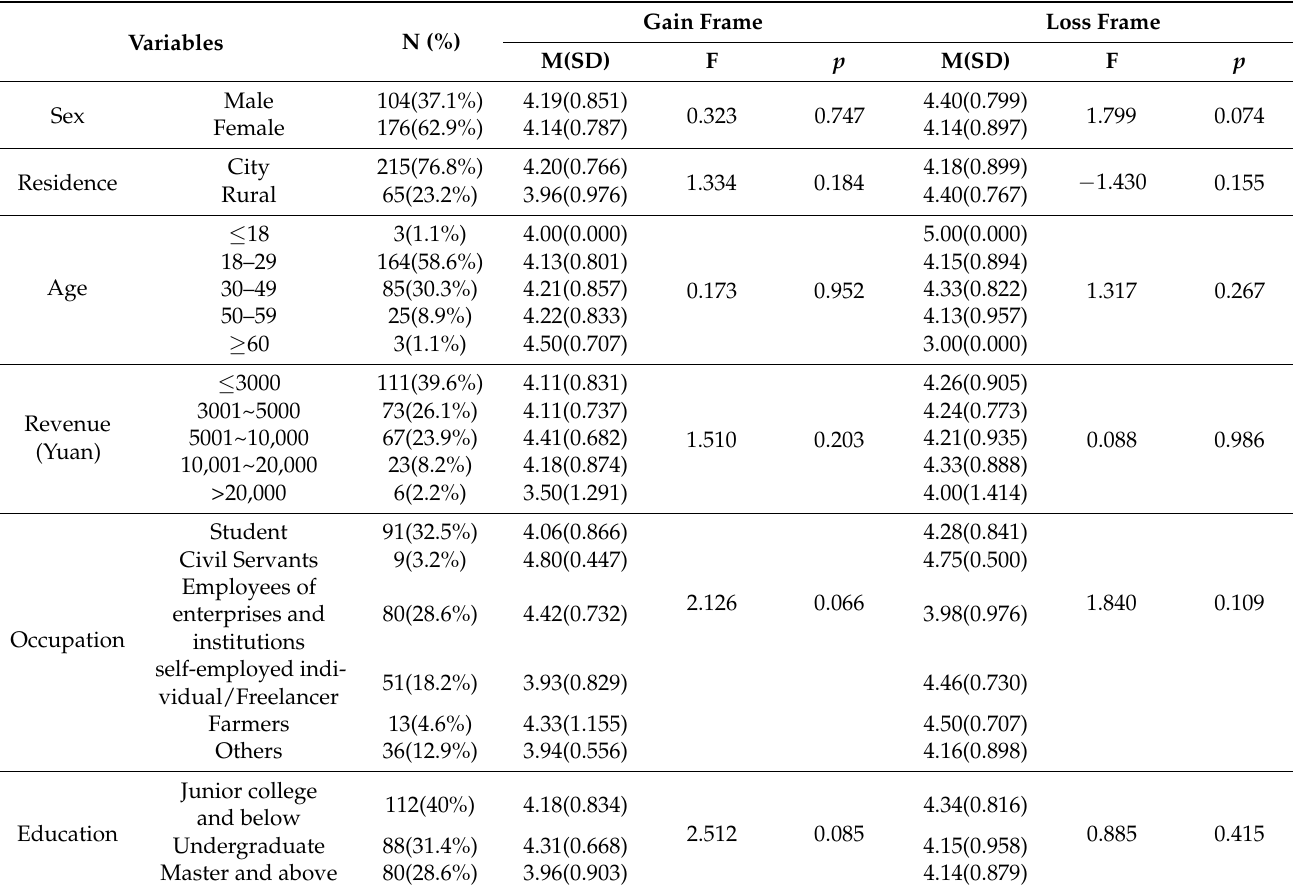
Table 2. Effect of demographic characteristics on vaccination intention based on information